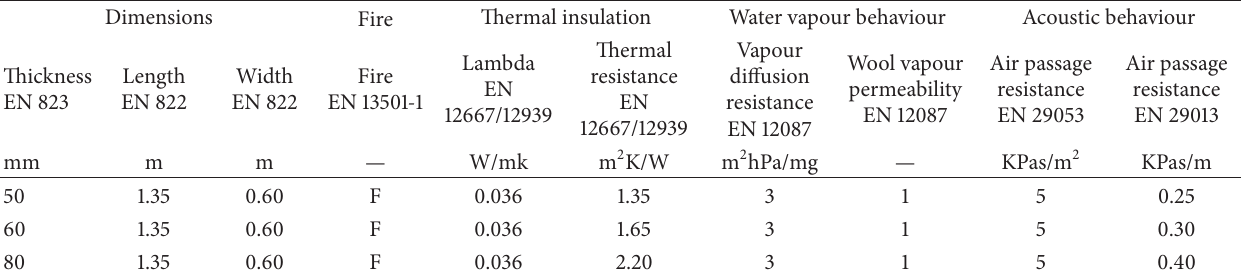
Table 4: Technical characteristics of the glass wool panel used in the research [14]. Dimensions